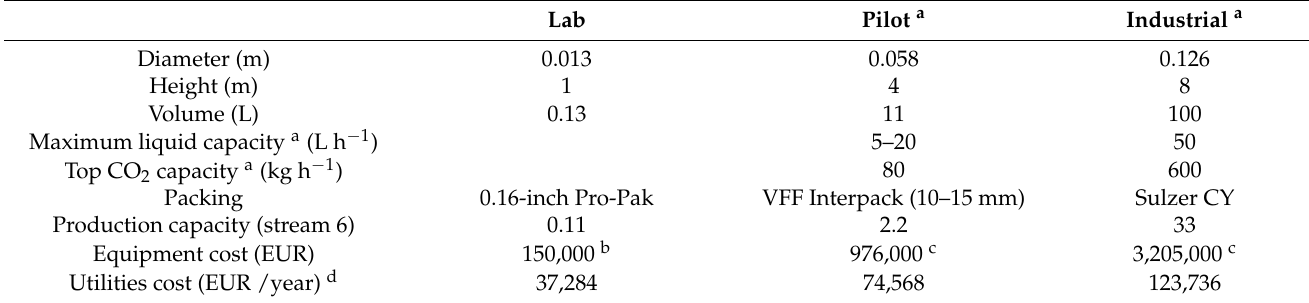
Table 1. Dimensions, packings, capacities, and costs of the scaled SFEE